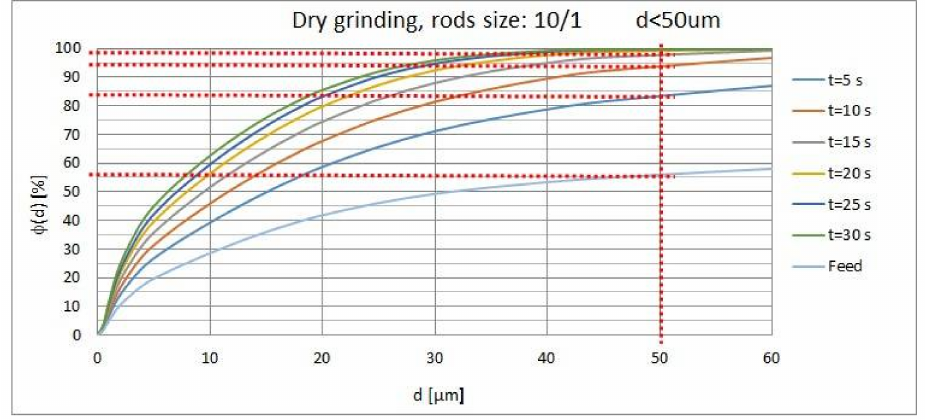
Figure 9. Cumulative volume distribution of grains with size lower then 50 µ m in the dry grinding